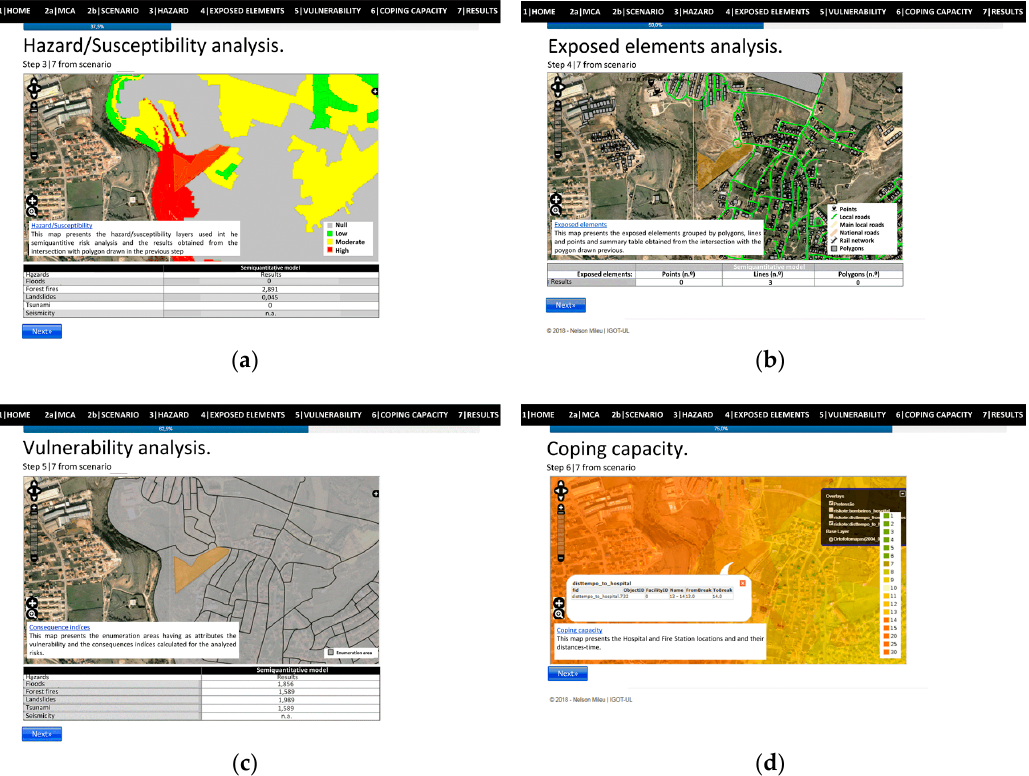
Figure 8. RiskOTe SDSS analysis steps: ( a ) Hazard; ( b ) Exposed elements; ( c ) Vulnerability/consequence indexes; ( d ) Coping